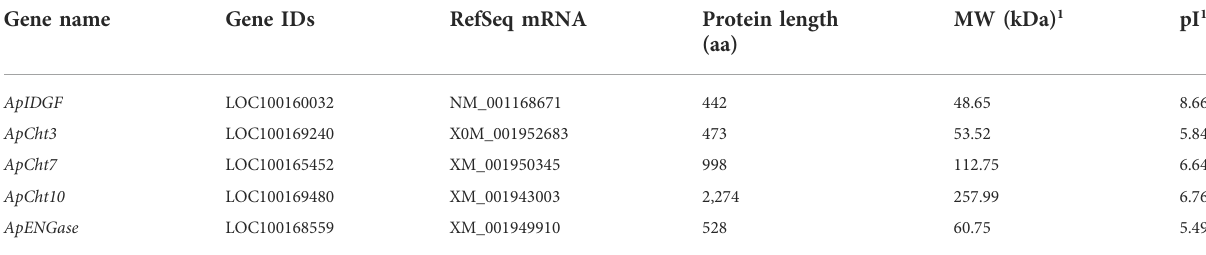
TABLE 1 List of the chitinase genes characterization in the Acyrthosiphon pisum